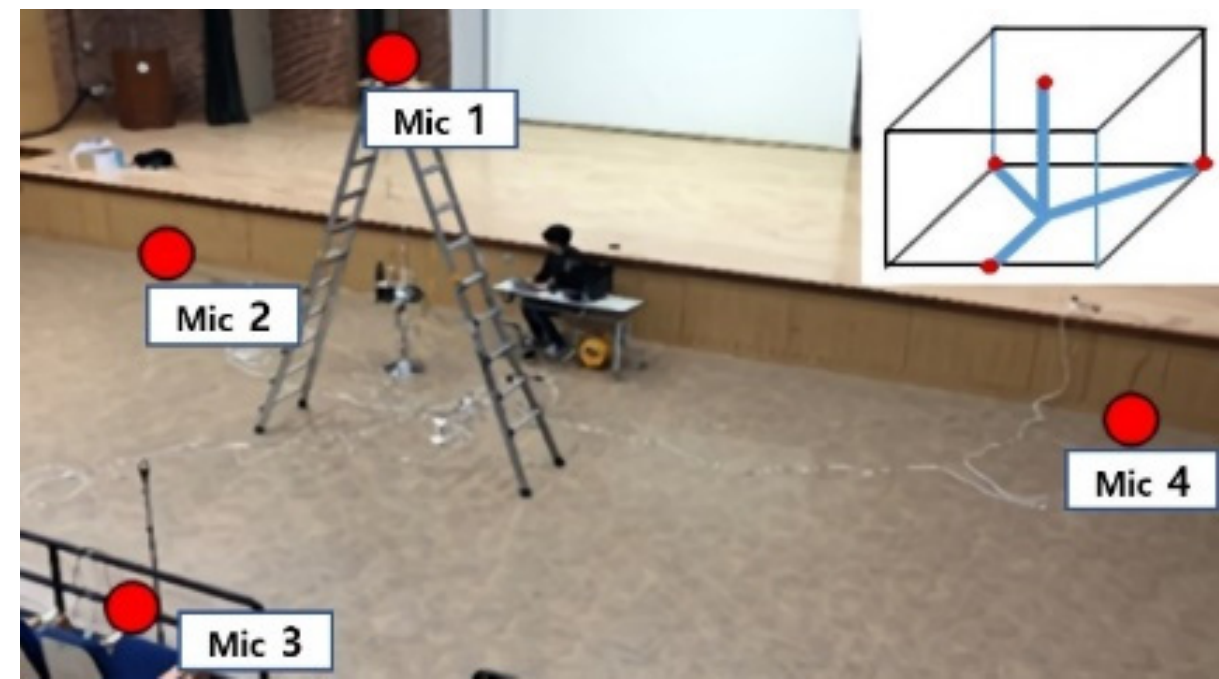
Figure 7. Preliminary tests with a right-angled pyramidal array.